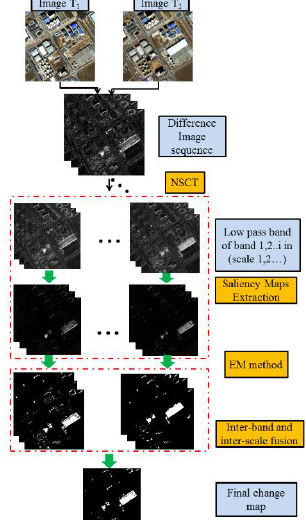
Figure 1. Framework of the proposed